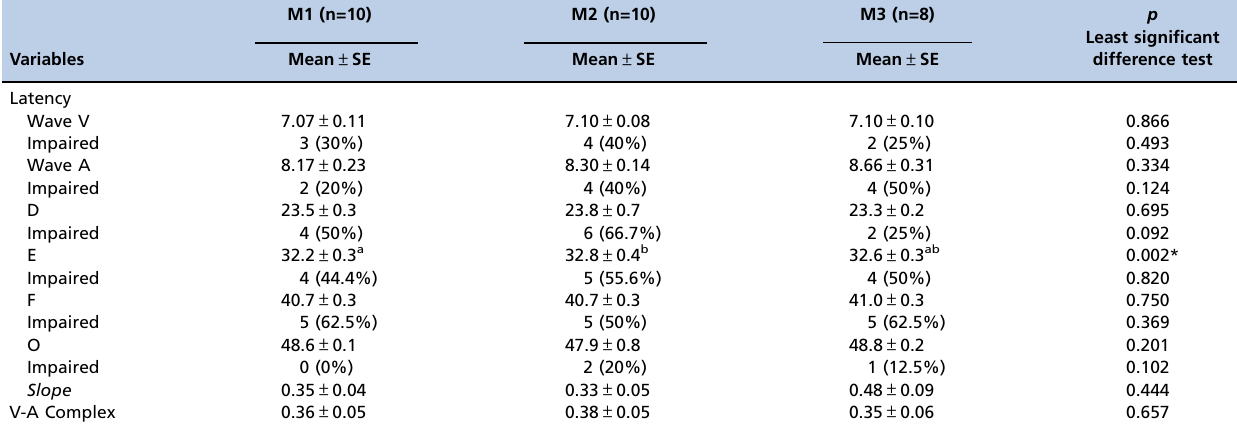
Table 5 - Descriptive latency (ms) values of the FFR components and p -values for comparison of progress at M1, M2, and M3.